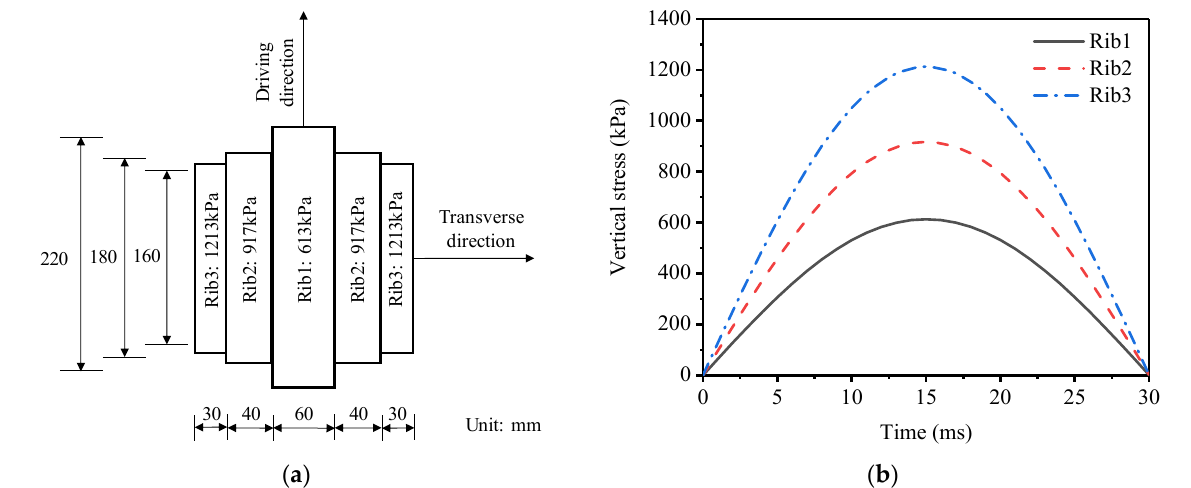
Figure 5. Load model in this paper: ( a ) Load distribution. ( b ) Vertical stress over time.